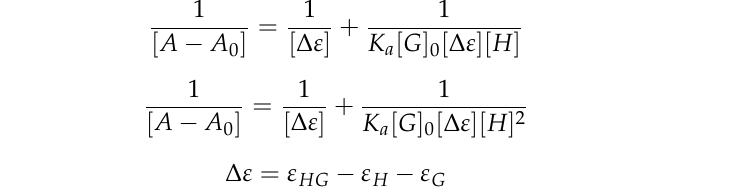
Figure 7. ( A ) At 25 °C, the UV-vis spectra of the 3 × 10 − 5 mol ∙ L − 1 DPG solution with different concen- trations of β -CDP (C β -CD : β -CD unit in β -CDP, mmol/L): (a) 0, (b) 3, (c) 6, (d) 9, (e) 12, (f) 15, (g) 18, (h) 21, and (i) 24. ( B ) Plot of